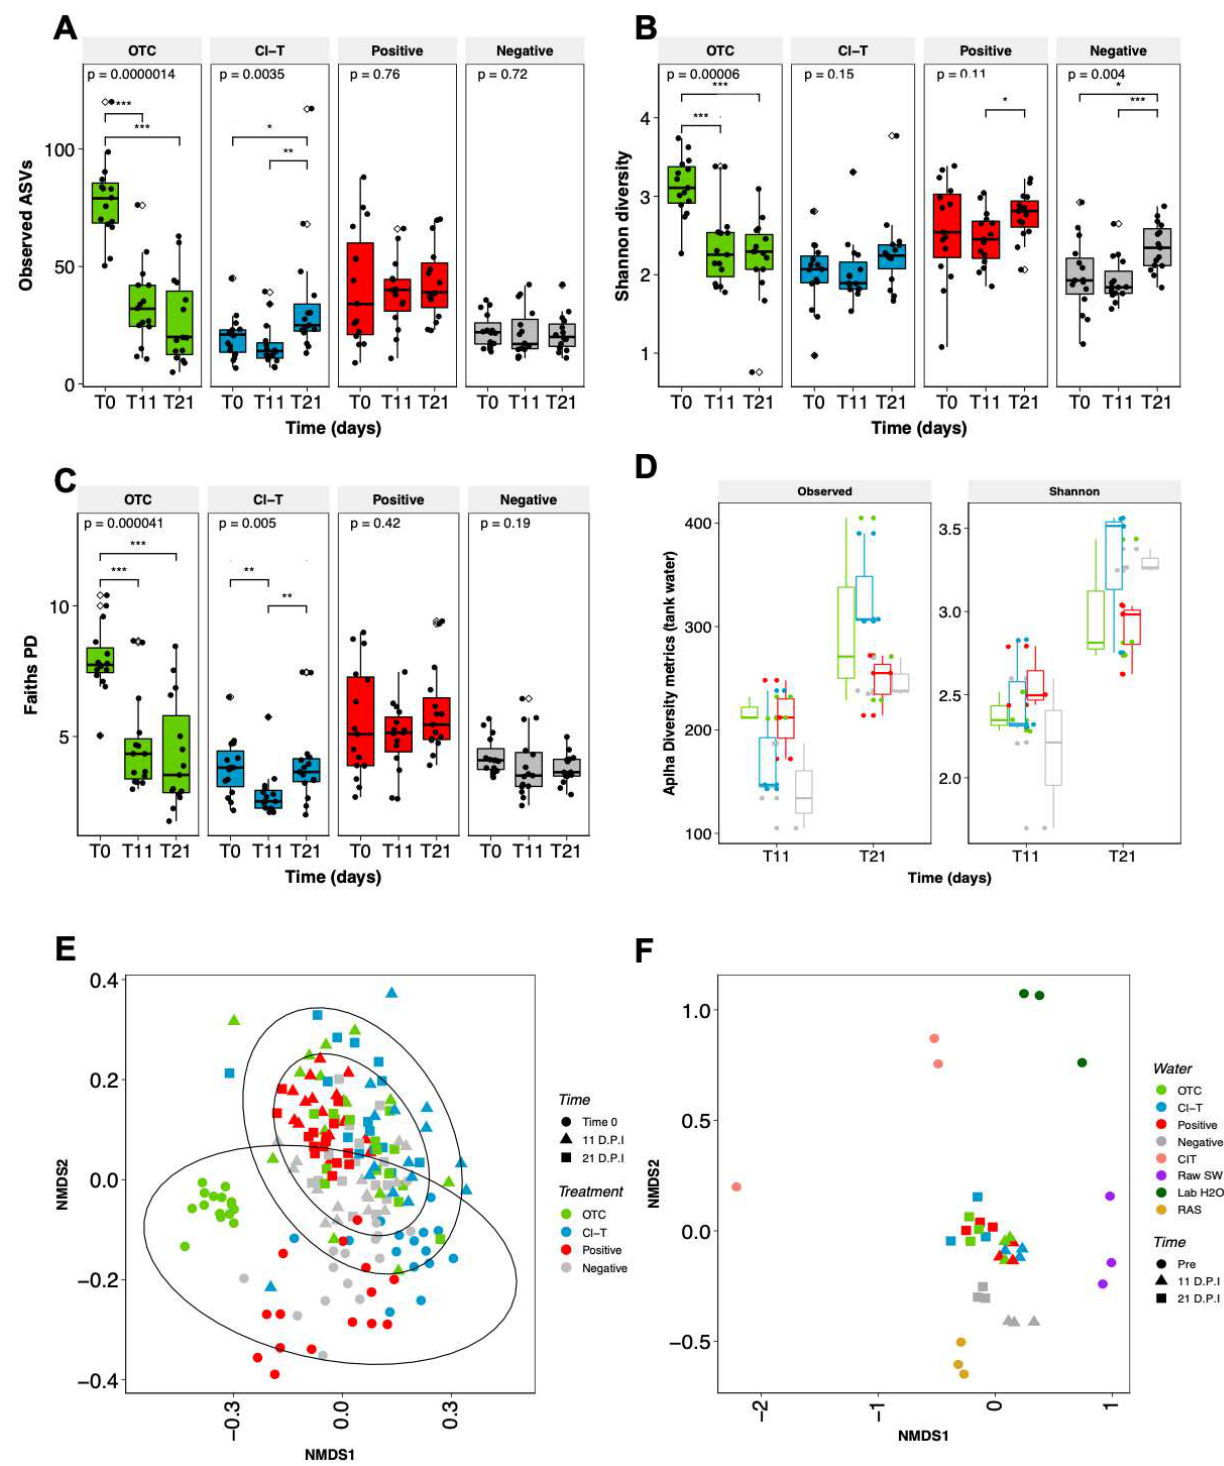
Figure 4. Alpha richness ( A ) expressed as Observed ASVs, and community diversity metrics ( B , C ) Shannon index and Faiths PD for gill mucus communities, along with Observed ASVs and Shannon index recorded in trial tank water ( D ). Black dots represent each individual sample point, unfilled diamond shape indicates outliers. P = global significance (Kruskal Wallis), pairwise significance determined by a Wilcoxon test with p < 0.05, p < 0.01 and p < 0.001 represented by *, **, and ***. Beta diversity visualized through Bray Curtis NMDS plots for ( E ) fish gill mucus and ( F ) holding tanks/water sources used in the